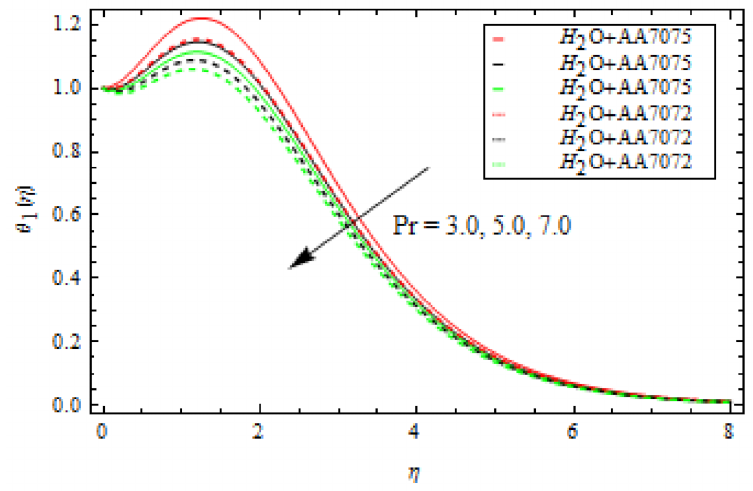
Figure 9. Influence of Prandtl number Pr on temperature